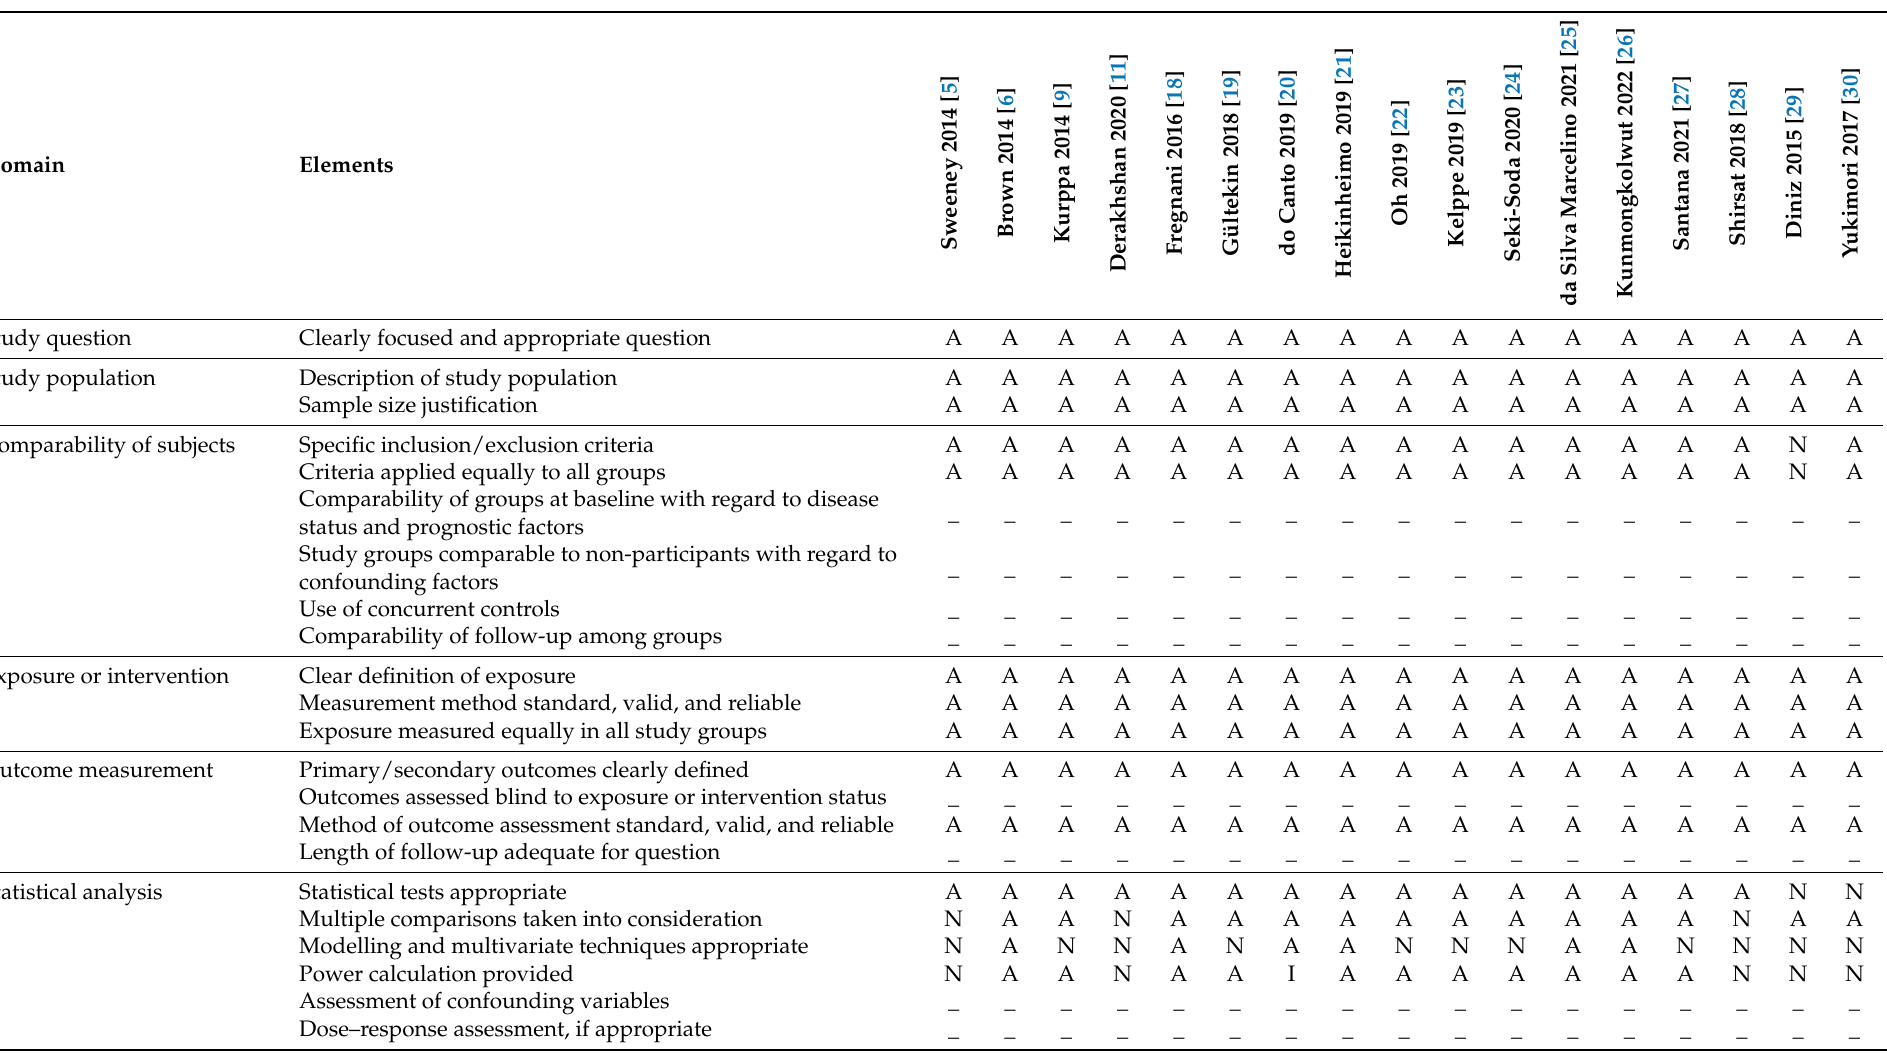
Table 2. Risk of bias among studies